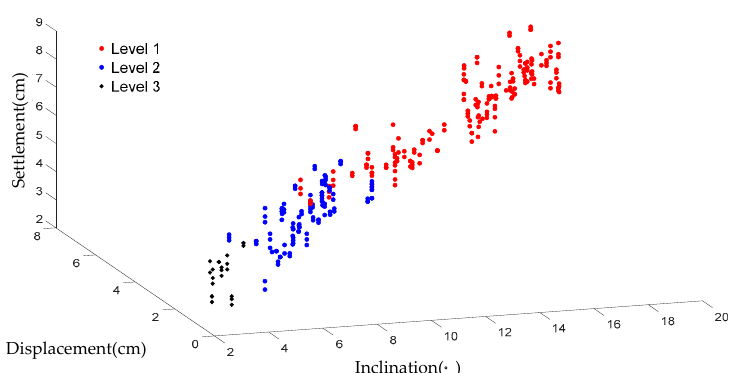
Figure 17. The damage level classification result evaluated by the empirical criteria.